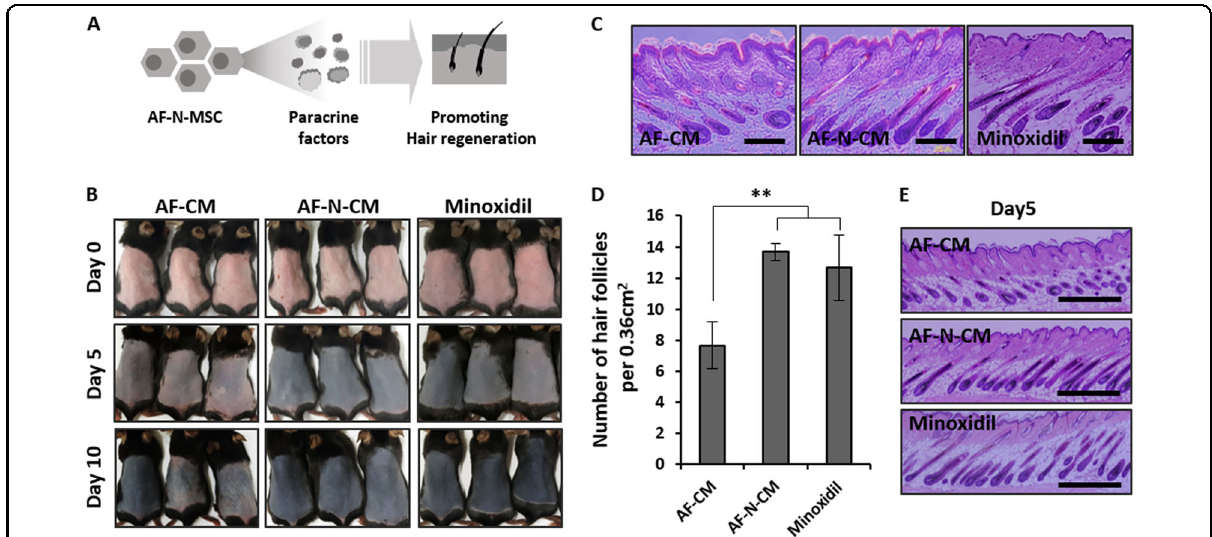
Fig. 5 Increased hair growth in mice by amniotic fl uid – derived mesenchymal stem cell overexpressing Nanog (AF-N-MSC) – derived conditioned media (AF-N-CM). a Schematic of a process for assessing the effect of AF-N-CM on hair regeneration. b Digital images of the dorsal skin of telogen C57BL/6 mice treated with AF-CM, AF-N-CM, or minoxidil. Stages of the hair cycle were determined by comparing dorsal skin colors. c Representative hematoxylin – eosin (H&E) images of dorsal skin sections for determination of hair follicle (HF) number and cycle. Scale bar, 200 µm. d HFs in 0.36 cm 2 . e H&E-stained dorsal skin section 5 days post-depilation. Scale bar, 600 µm. Data are represented as the mean ± SD ( n = 3). ** p <